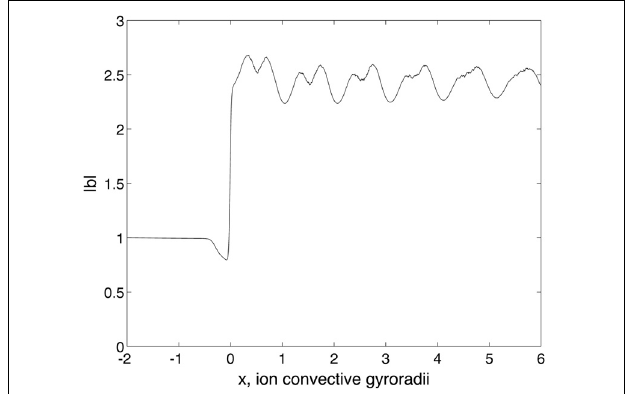
FIGURE 1 | Magnetic field magnitude calculated from the pressure balance condition (9) with the ion distribution obtained numerically. The coordinate is in the upstream convective gyroradii. Details in text.